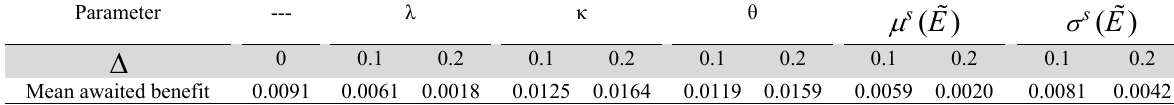
The mean awaited benefit by the impact of errors in